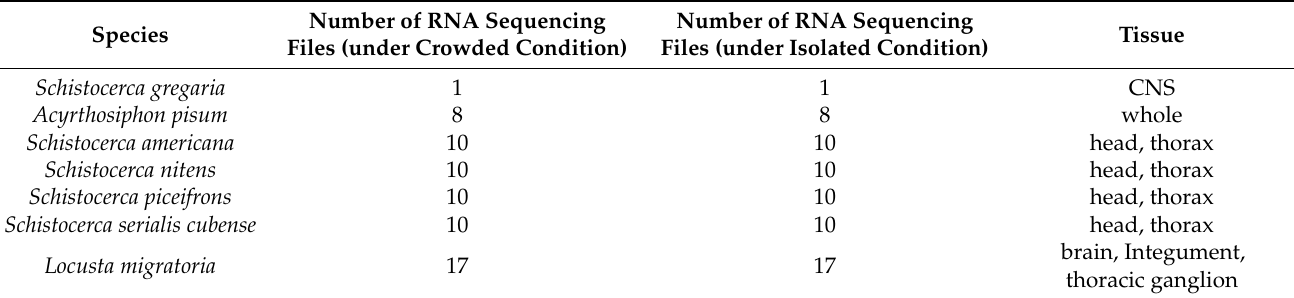
Table 1. Summary of datasets used in this